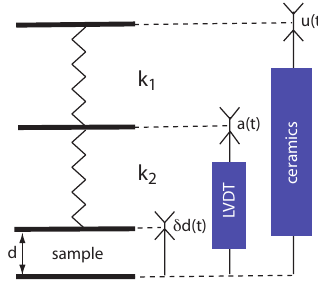
Figure 12. Equivalent mechanical model of the rheometer. The linear variable differential transformer (LVDT) is a very precise linear displacement transducer. It is used to measure a ( t ) when the cell is filled with the LC and u ( t ) when the cell is